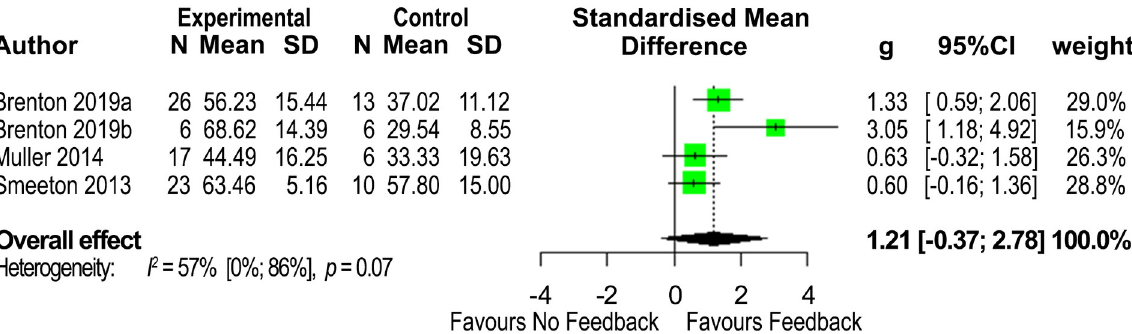
Fig 2. Forrest plot displaying the Hedge’s g effect sizes and 95% confidence intervals (CIs) for the perception attribute of anticipation, exploring accuracy among cricketers for feedback-involved intervention groups compared to no-feedback control groups.